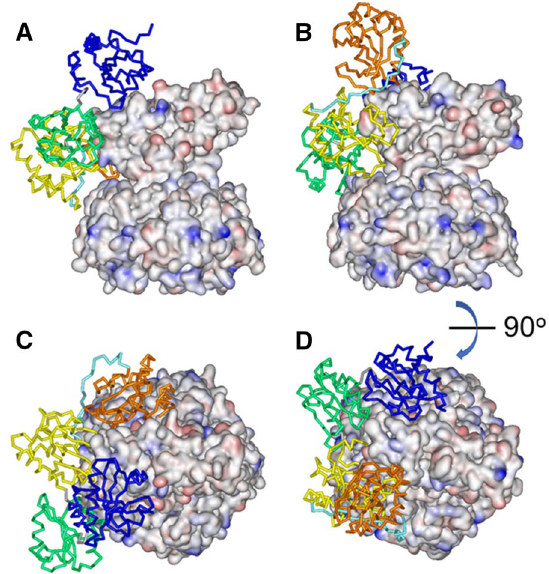
Figure 8. Models for interaction of reduced PDI, shown in ribbon format, with CT ( A , C ) and LT ( B , D ), shown in electrostatic surface format. ( A , B ) The toxins are presented in side-view orientation. ( C , D ) The structures are rotated about a horizontal axis by 90° to generate top views. Toxin surface coloring reflects the electrostatic charge: blue = positive charge, red = negative charge, white = neutral. PDI coloring is domain-specific: a = blue; b = green, b ′ = yellow, x = cyan, a ′ = orange (from N- to C-terminus). The structures of CT, LT, and PDI are derived from PDB entries 1s5f, 1lts, and 4ekz, respectively. Images have been rendered by Viewer Lite